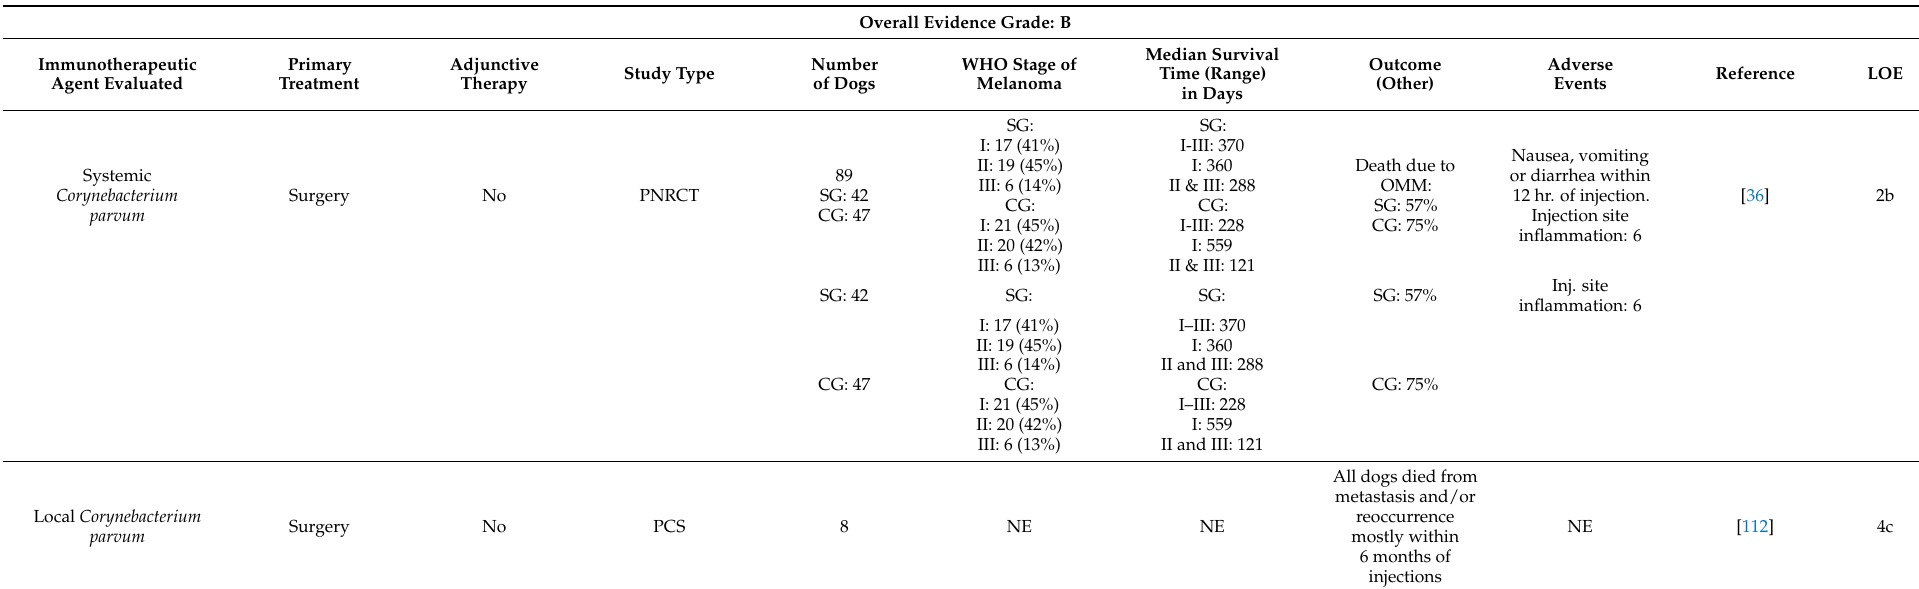
Table 15. Summary of bacterial inoculation studies evaluating effectivity in oral malignant melanoma. Overall Evidence Grade: